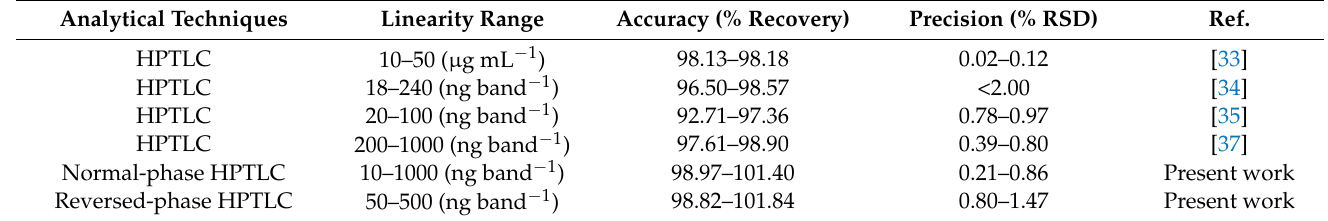
Table 6. Comparison of the current normal/reversed-phase HPTLC technique with reported techniques for the determina- tion of